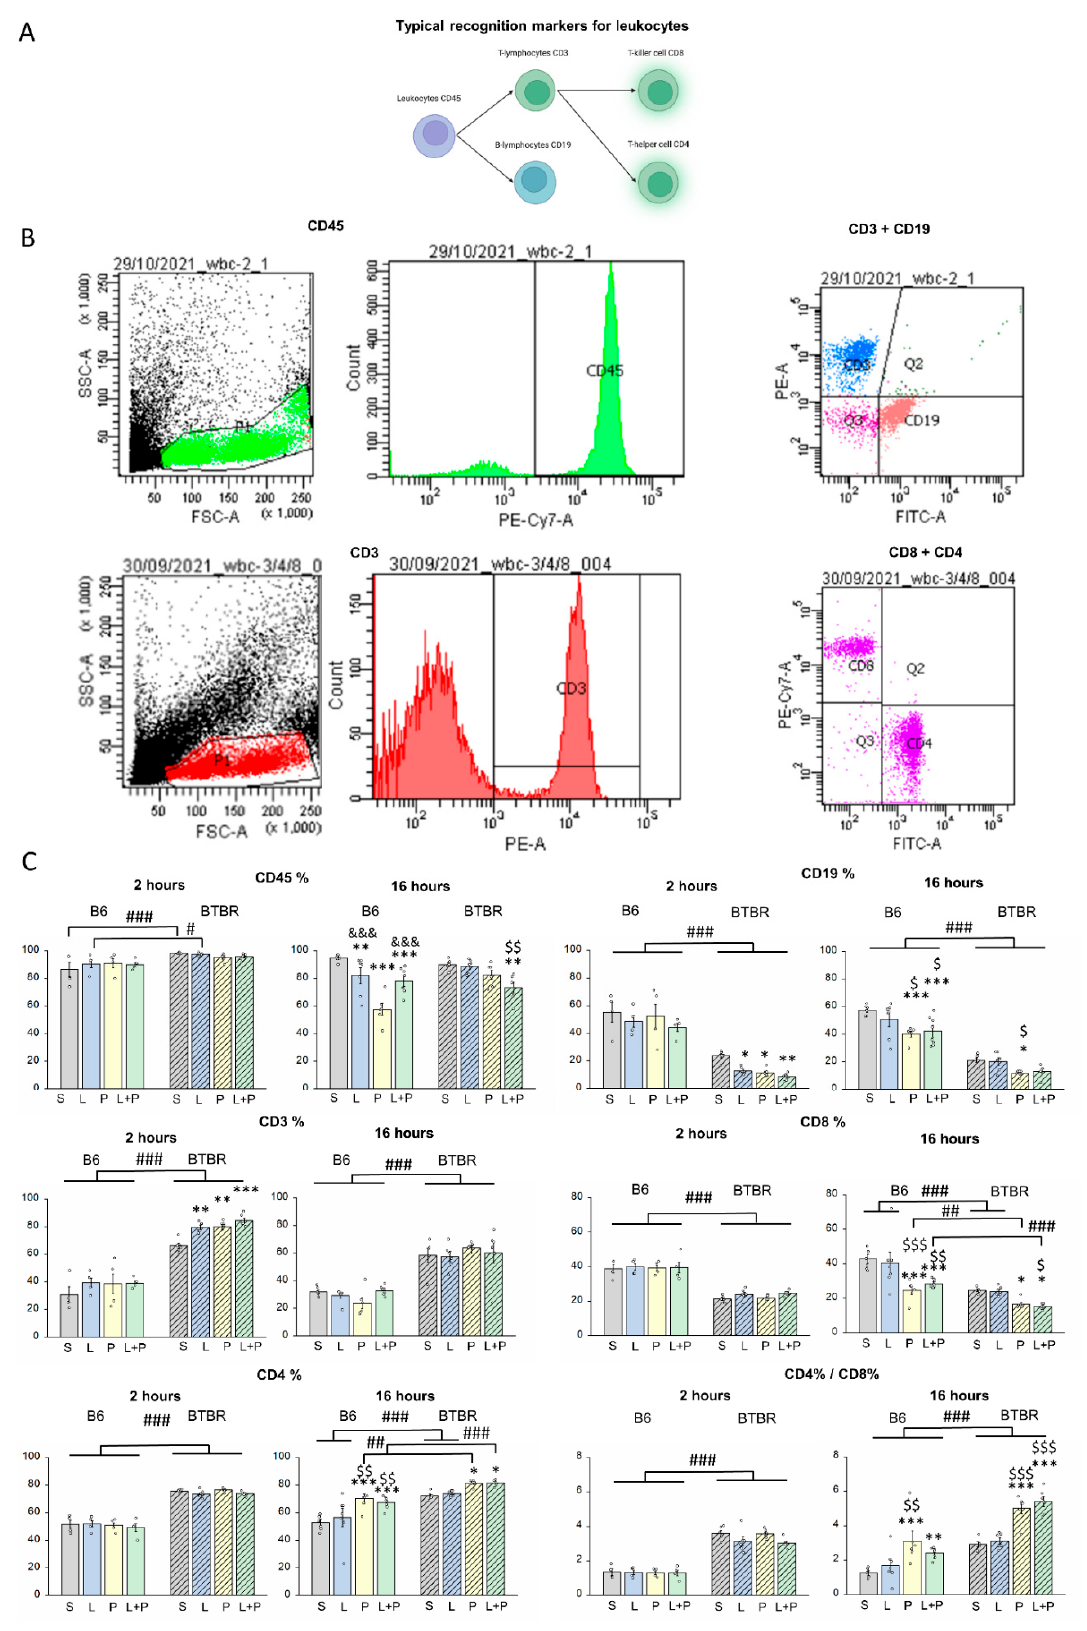
Figure 3. ( A ) Results of different types of lymphocytes. Typical markers of lymphocytes were assayed; ( B ) the gating strategy for evaluating the distribution CD3 + T cells, CD19 + B cells, CD4 + T helper cells, and CD8 + cytotoxic T lymphocytes; and ( C ) changes in the ratio of types of lymphocytes